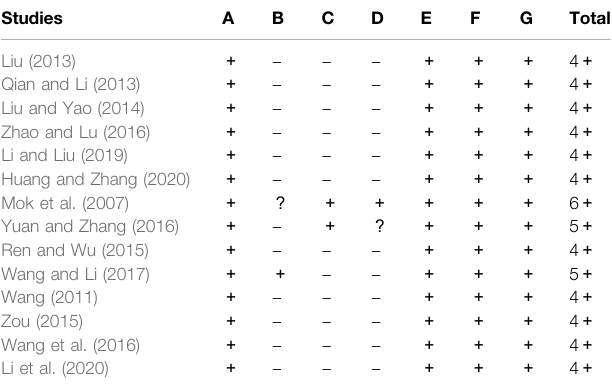
TABLE 3 | Risk of bias assessment of all included